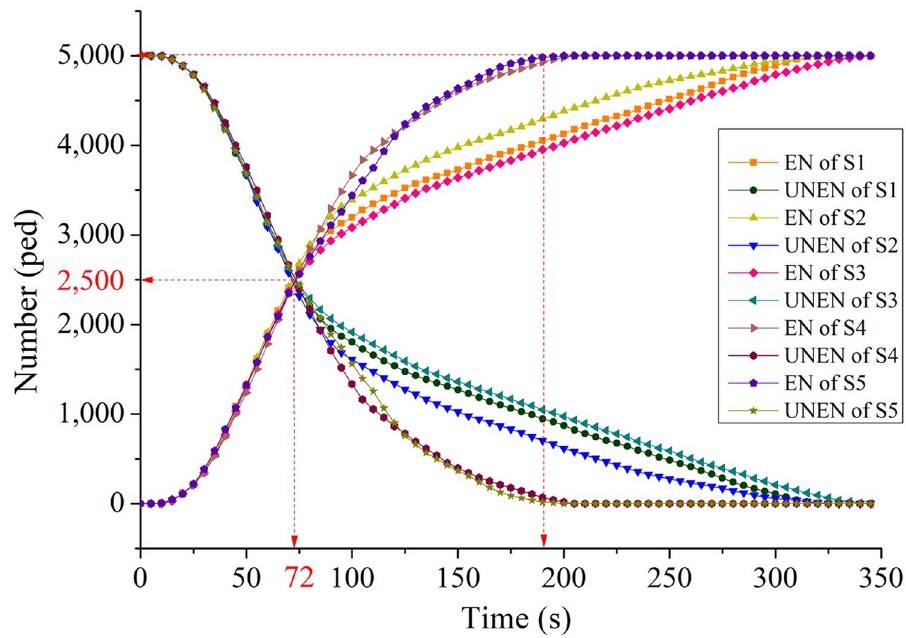
Fig 8. Number of Evacuated and non-evacuated